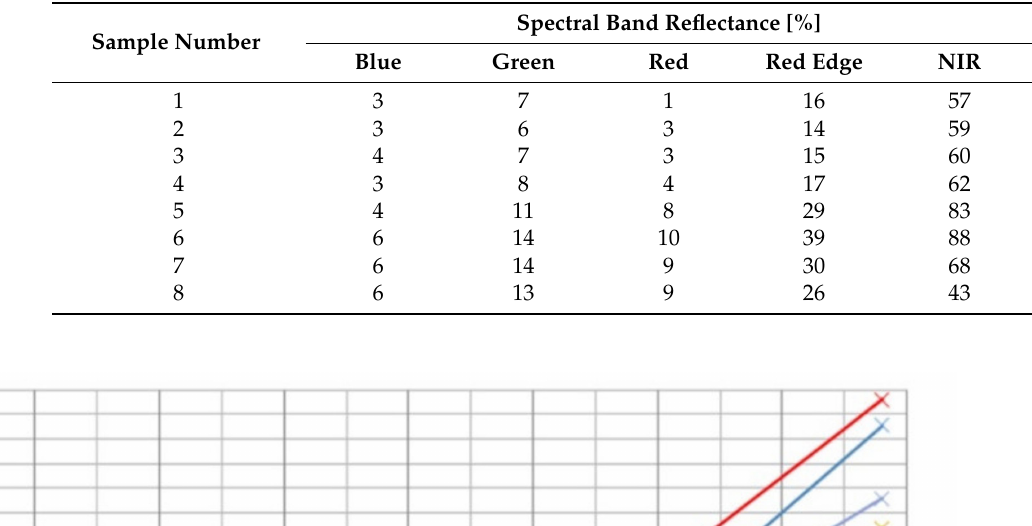
Table 3. Evaluation of the vegetation reflectivities at the individual sampling stages.